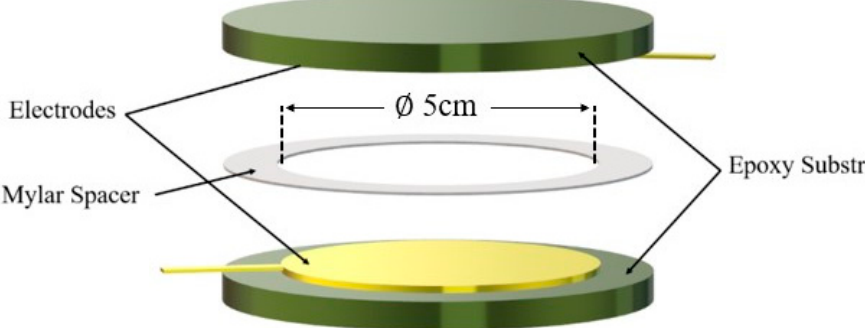
Figure 14. Illustration of the mold used to develop 0–3 and 1–3 composites. Figure 14 . Illustration of the mold used to develop 0 – 3 and 1 – 3 composites. Figure 14 . Illustration of the mold used to develop 0–3 and 1–3 composites.